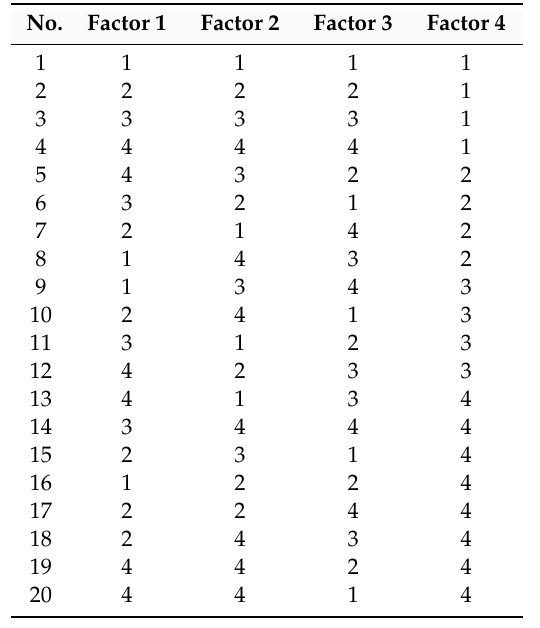
Table 1. Orthogonal test